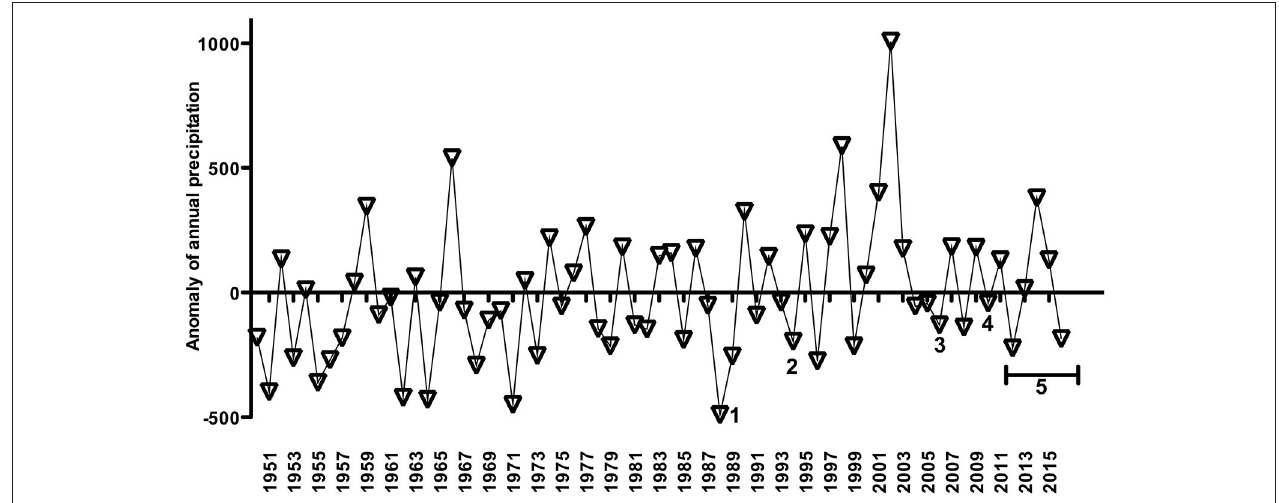
FIGURE 6 | Cyanobacteria blooms or non-blooms estimates published and of this work (summers of 2012, 2013, 2014, 2015, 2016, and 2017) overlaid with an anomaly of rainfall time-series as in Figure 3B . Note that the anomaly of rainfall time-series ends in 2016. 1 refers to Odebrecht et al. (2005), and 2 Yunes et al. (1998a), 3 and 4 Rosa and Garcia (2013), and 5 refers to cyanobacteria estimates near the cities of Tapes and São Lourenço do Sul (offered by FEPAM, Brazil) (see text for more